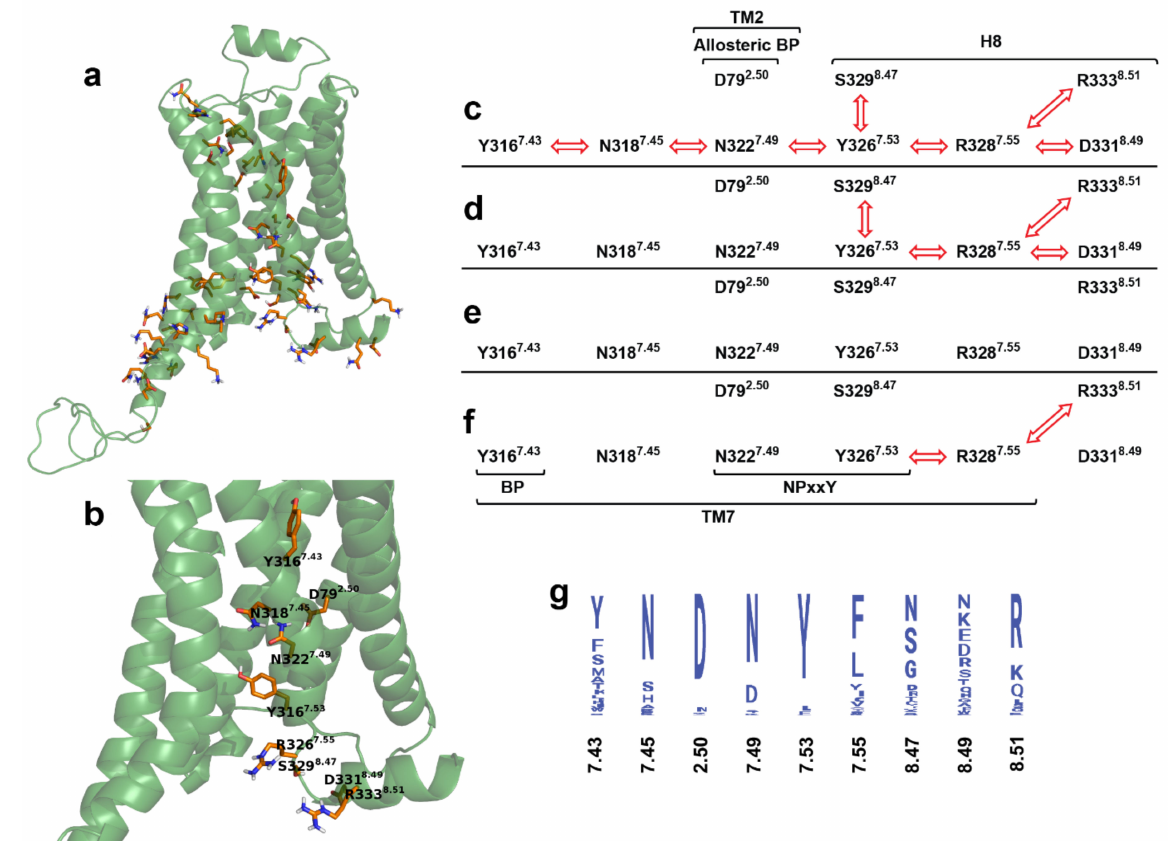
Figure 6. The polar signaling channel of the β 2 AR identified by dynamic cross-correlation analysis. ( a ) Polar amino acids of which motions are correlated in the G s protein-bound active state. ( b ) Polar amino acids of which motions are correlated and connecting the orthosteric binding pocket to the G protein-binding interface. Non-polar hydrogens are omitted for clarity. ( c ) Active β 2 AR–G s protein–epinephrine complex, 1st replica; ( d ) inactive β 2 AR–G s protein–epinephrine complex; ( e ) active β 2 AR– β -arrestin-2–epinephrine complex; ( f ) inactive β 2 AR– β -arrestin-2–epinephrine complex. Red arrows indicate correlated motions of the respective amino acids. ( g ) Degree of conservation of polar signaling channel residues of human class A